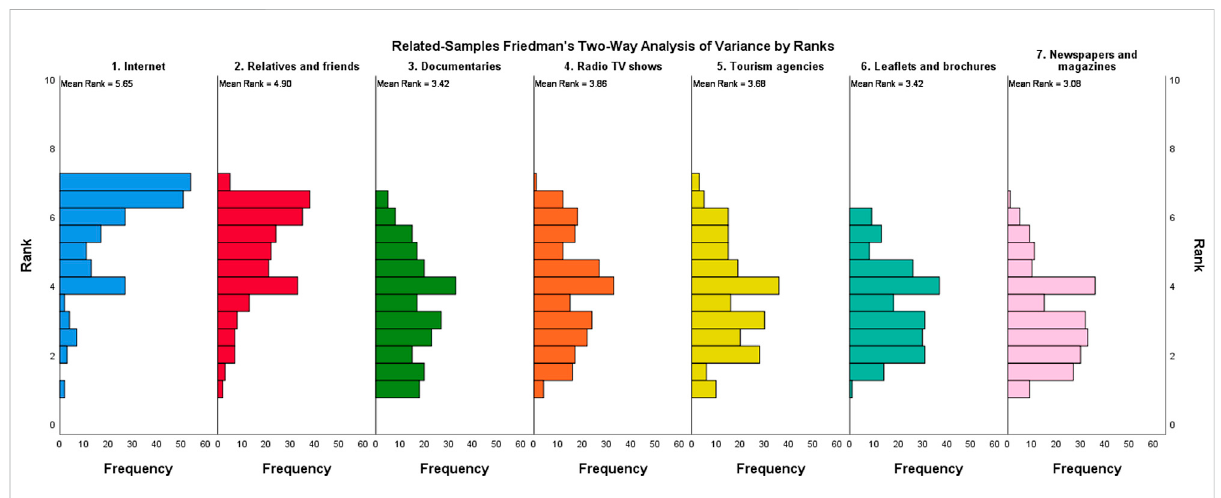
FIGURE 10 Sources ofinformation-related samples Friedman ’ stwo-way analysis ofvariancebyranks summary ( N = 218; teststatistics:360.628; degree of freedom: